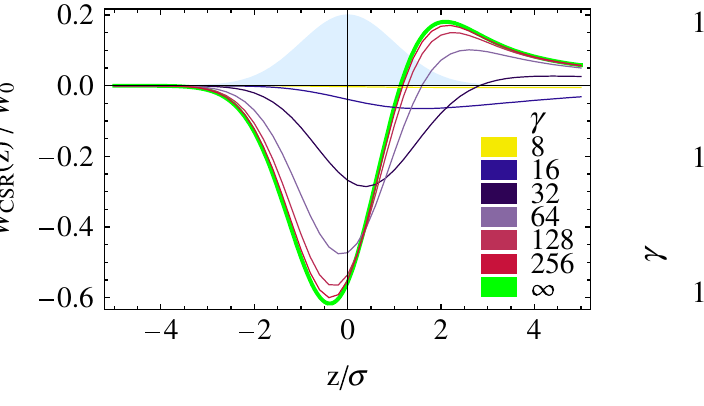
FIG. 3. (Color) The steady-state CSR wake for various relativ- istic (cid:6) using Eq. (32), compared to Eq. (36) plotted as green. Here (cid:7)(cid:10) ¼ 3 (cid:5) 10 (cid:1) 5 for a Gaussian bunch, represented in light blue.